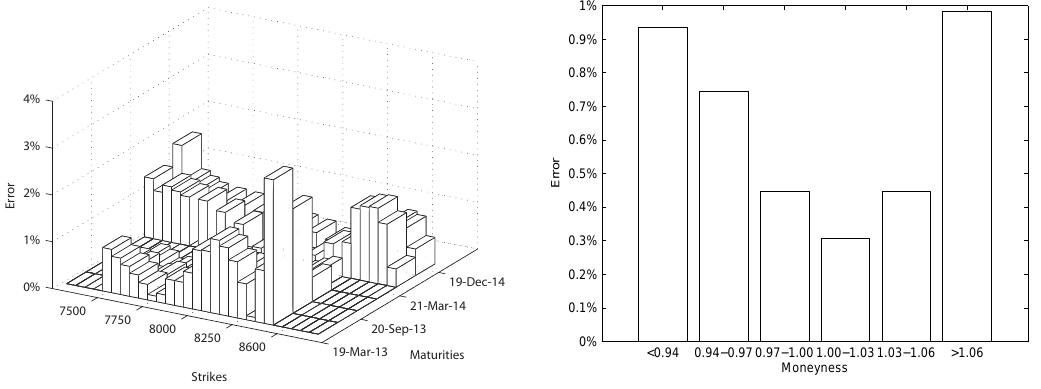
Fig. 8. Results for lsqnonlin . The left picture portrays the absolute relative errors. The right picture shows the average absolute relative errors in terms of moneyness. The initial point was provided by